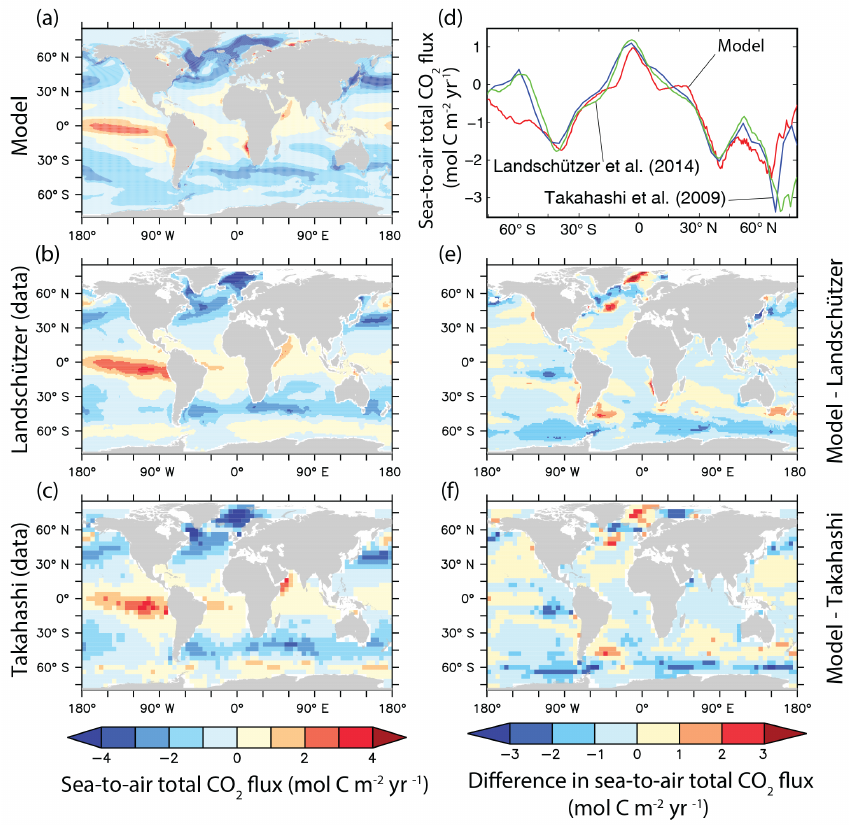
Figure 3. Climatological mean of sea-to-air flux of total carbon fluxes in molCm − 2 y − 1 for (a) the model average during the 1993–2012 period, (b) the data-based estimate from Landschützer et al. (2014) for 1998–2011, and (c) the data-based estimate from Takahashi et al. (2009) for 2000–2009. Panels (d) and (f) present differences between simulated and observed sea-to-air total carbon fluxes (molCm − 2 yr − 1 ) relative to (b) and (c) respectively. Panel (d) presents the latitudinal distribution of the simulated and the observed mean sea-to-air total carbon fluxes. Table 3. Weighted mean of simulated and data-based sea-to-air CO 2 fluxes and simulated residence time for each MARCATS class, excluding the Sea of Okhotsk (see text). Abbreviations are included for eastern boundary current (EBC) and western boundary current